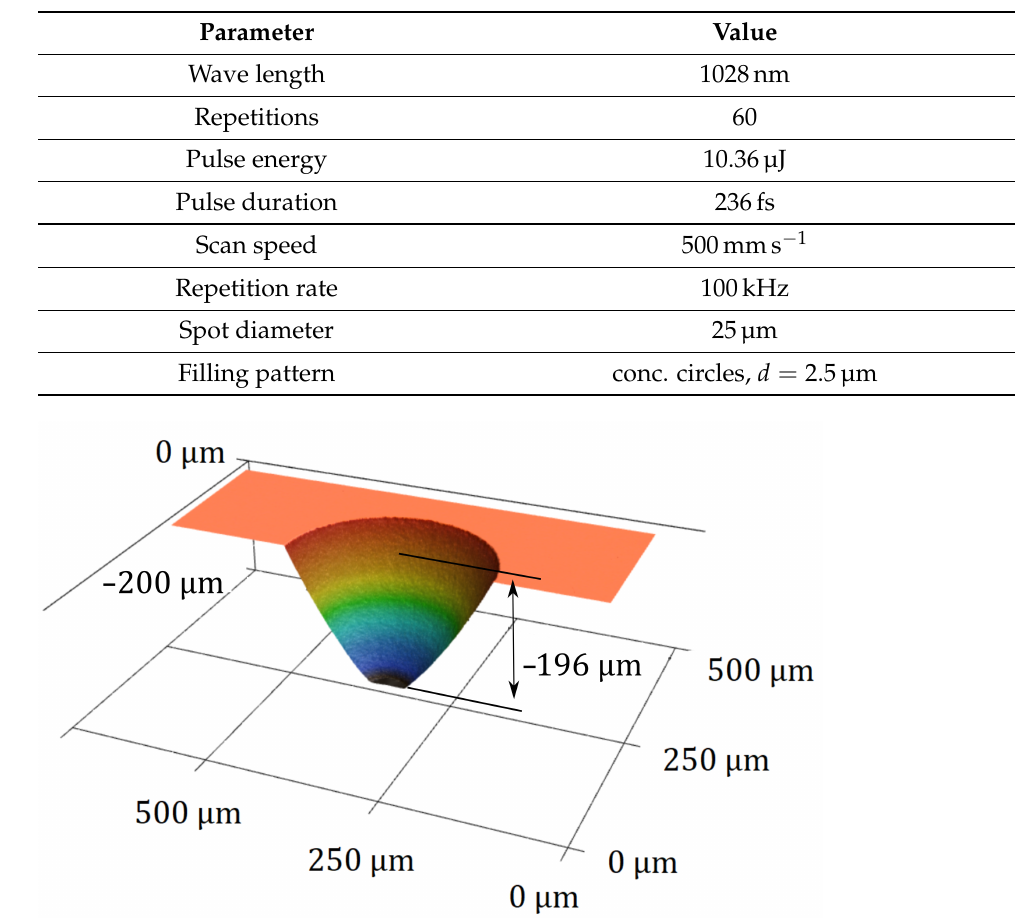
Table 1. Laser fabrication parameters for the through glass holes.